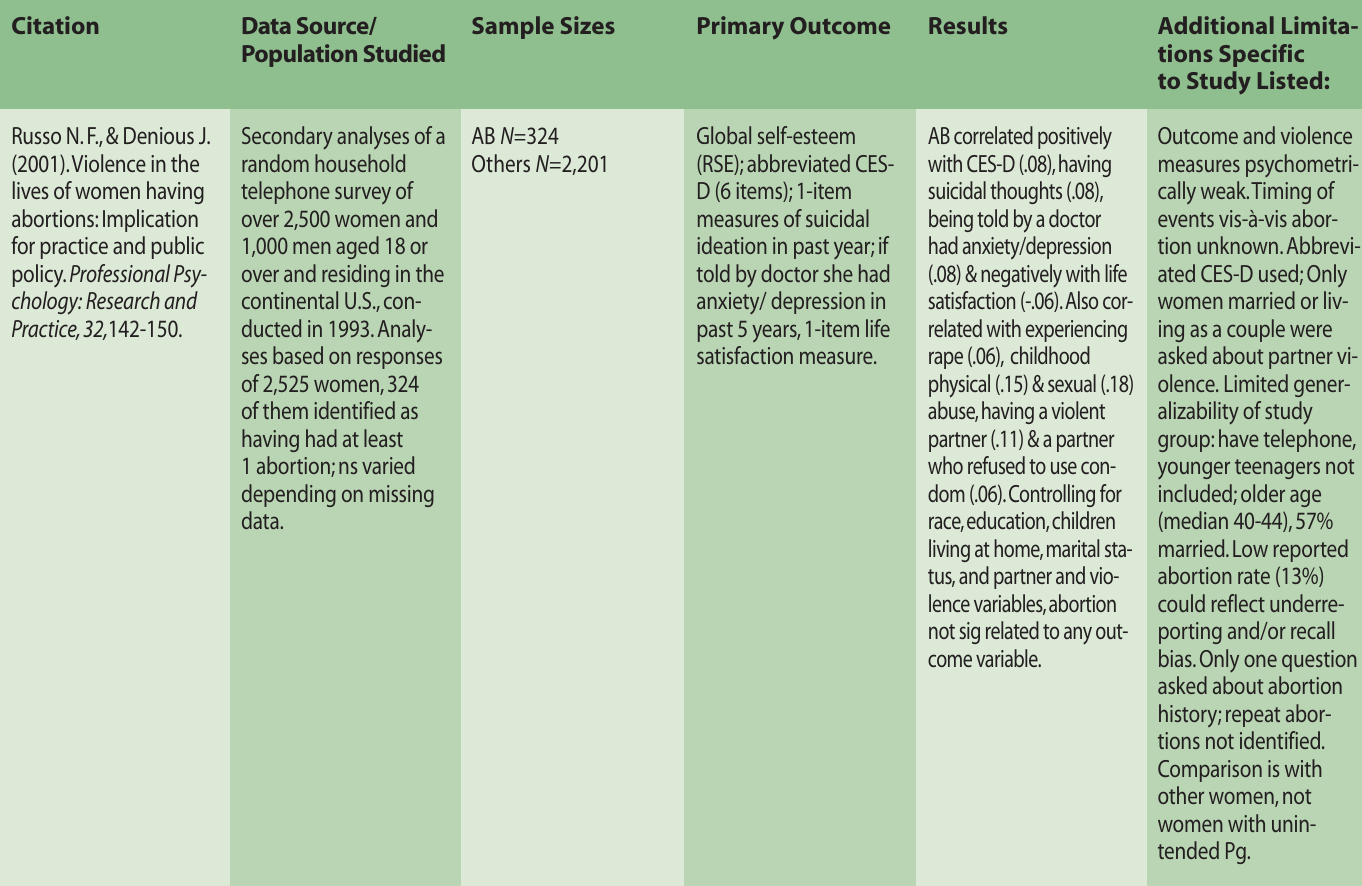
Table 2: Secondary Analyses of Survey Data–Abortion vs.Comparison Groups U.S.STUDIES